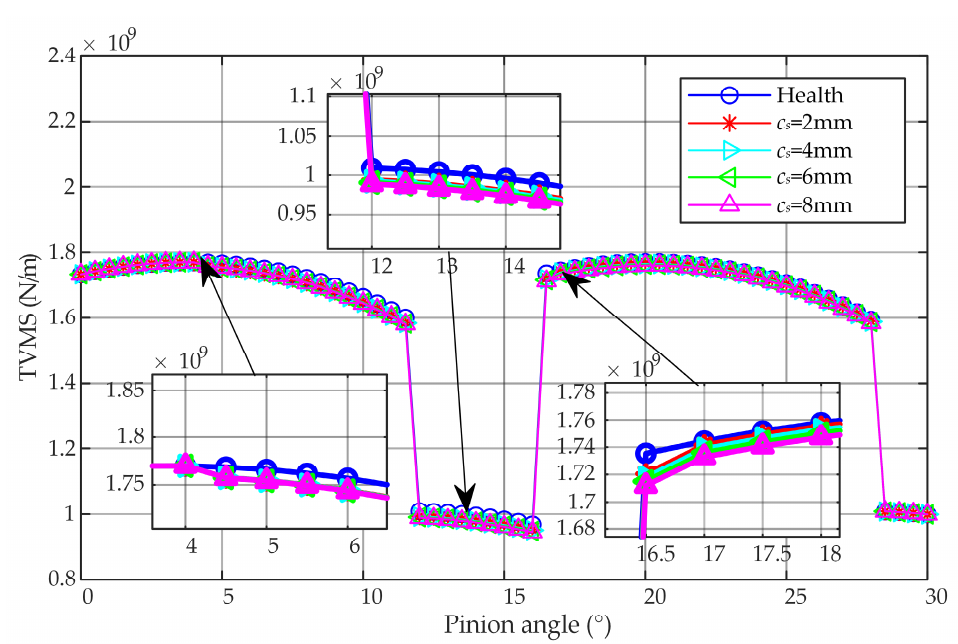
Figure 6. Comparison of TVMS of gears with different spalling depths under fixed length and width.